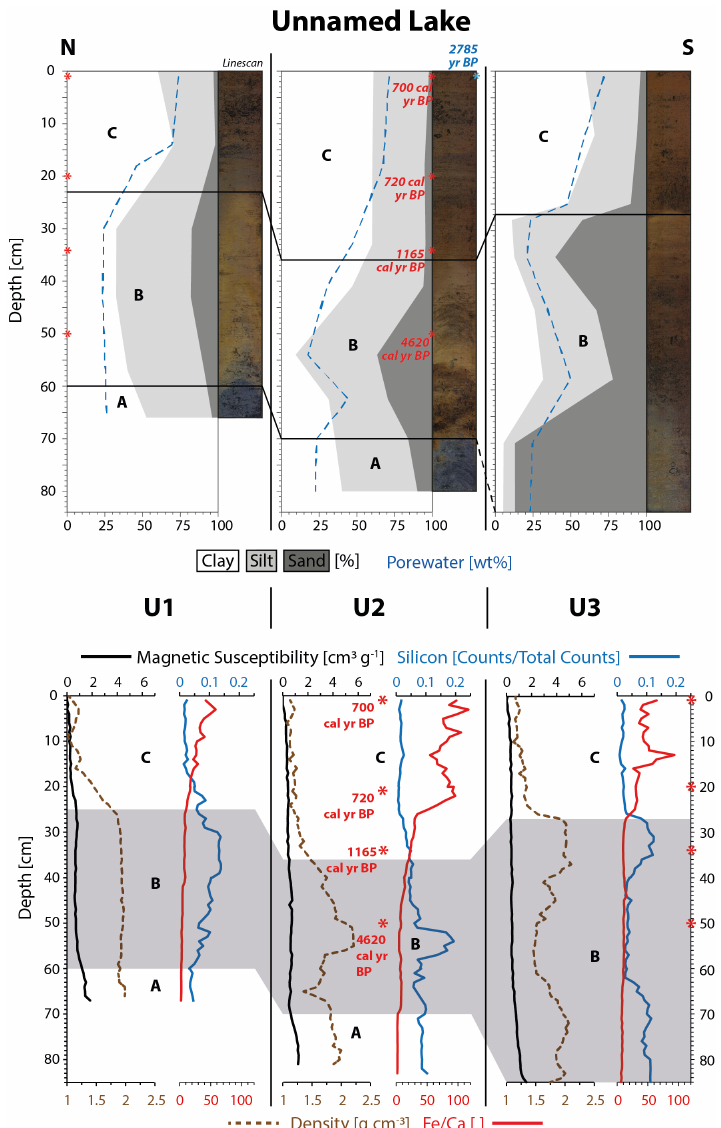
Figure 3. Physical property plots of cores U1–U3 from Unnamed Lake show the talik subdivided into three units (A, B, C). The taberite soil (A–B) is distinguishable from the overlying lake sediment (C), especially through sharp boundaries in color, porewater content, grain size, sediment density, and silicon content. A vertical radiocarbon macrofossil age profile (red numbers) and a bulk sediment age (blue number) at the sediment surface are displayed as rounded values in core